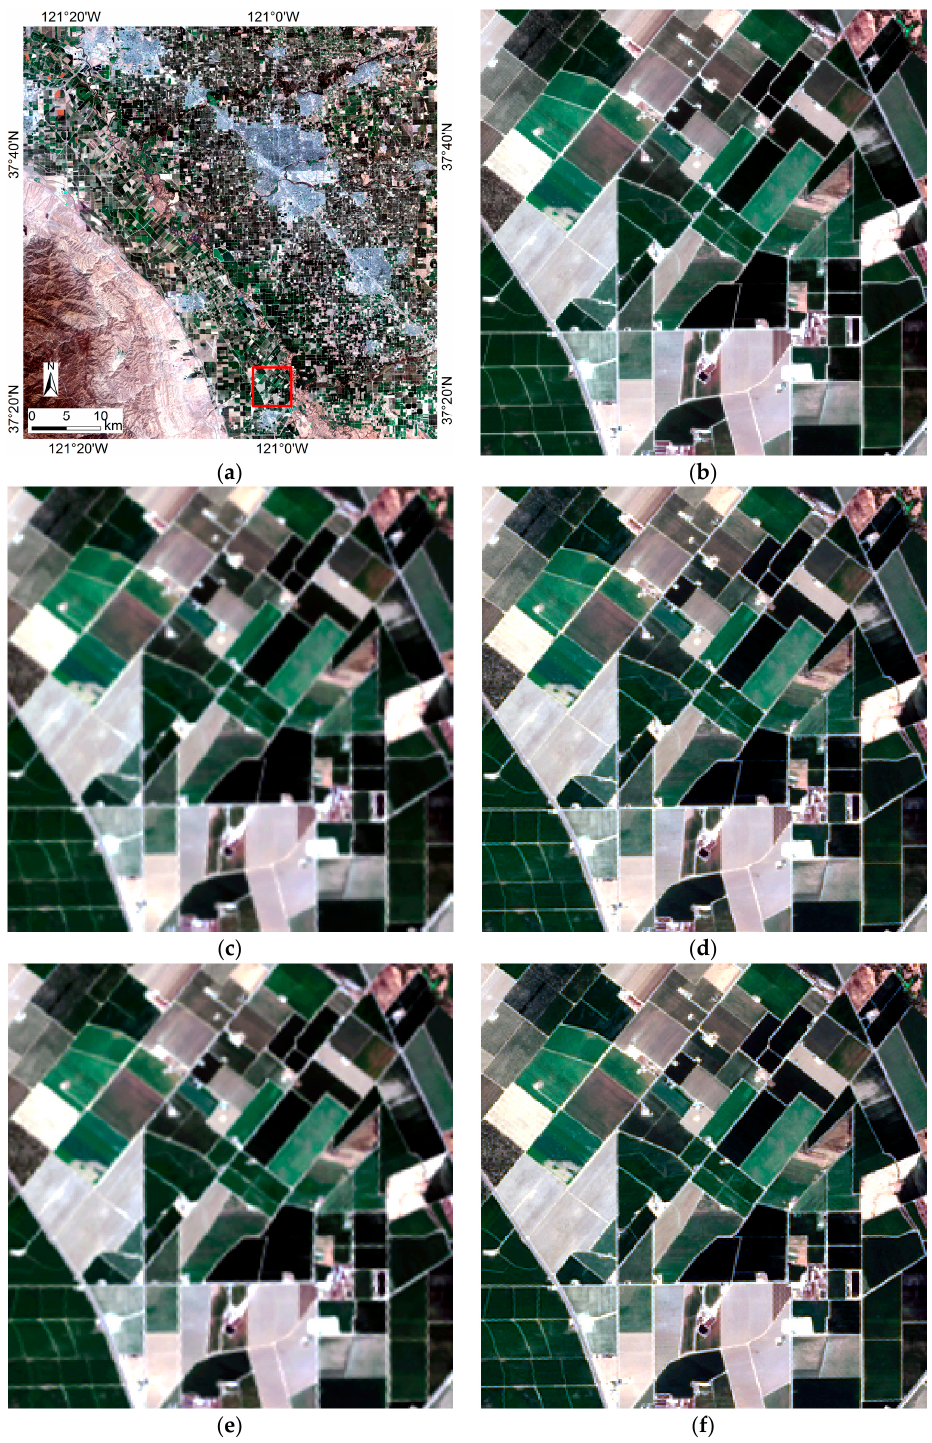
Figure 5. Crop field, California, true color images showing: ( a ) Sentinel-2A 20-m image (3000 × 3000 20-m pixels) and sub-set (red box); ( b ) Sentinel-2A 256 × 256 20-m pixel sub-set; ( c ) Landsat-8 bilinear resampled to 20 m; ( d ) Landsat-8 bilinear-based LPAD 20-m data; ( e ) Landsat-8 cubic convolution resampled to 20 m; ( f ) Landsat-8 cubic convolution-based LPAD 20-m data.